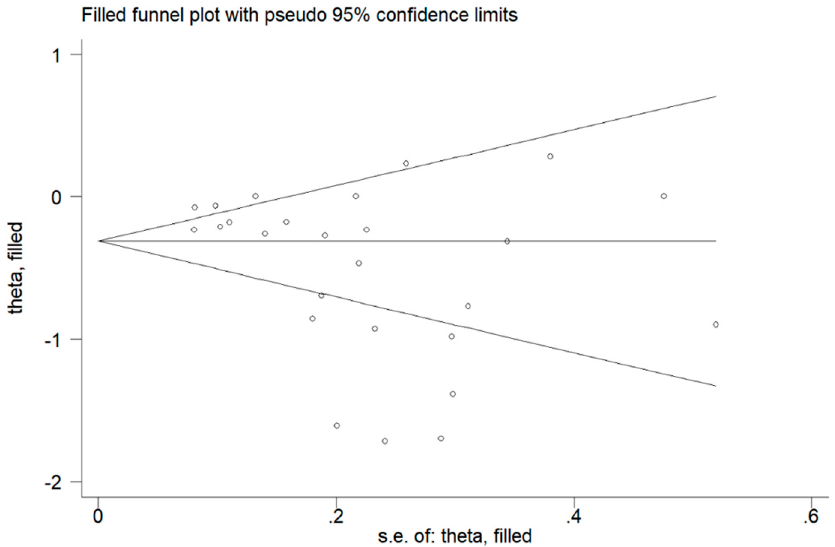
Figure 4. Funnel plot of studies investigating non-COPD controls and patients with COPD after trimming and filling. Dummy studies and genuine studies are represented by enclosed circles and free circles, respectively.